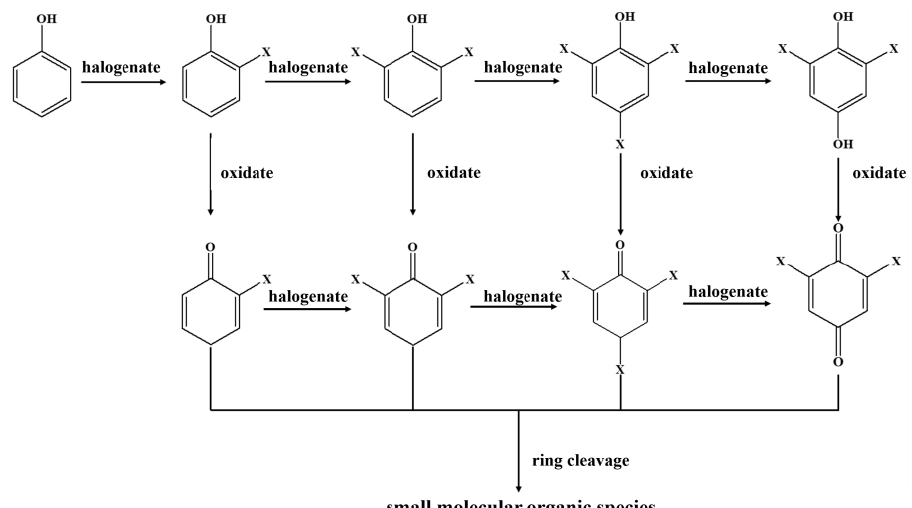
Figure 7. Possible transformation pathways of phenol during solar-driven seawater desalination by activated persulfate (X represents chlorine or bromine).